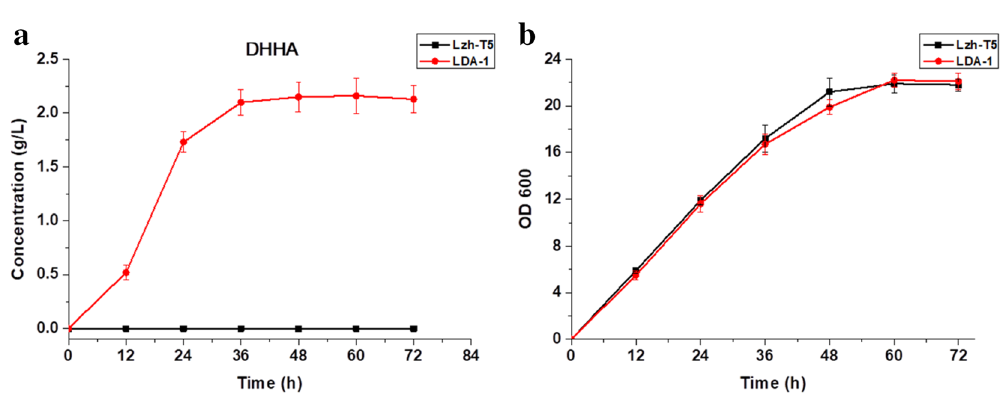
Figure 4. The DHHA production, growth curves of P. chlororaphis Lzh-T5 and LDA-1. ( a ) The DHHA production. ( b ) Growth